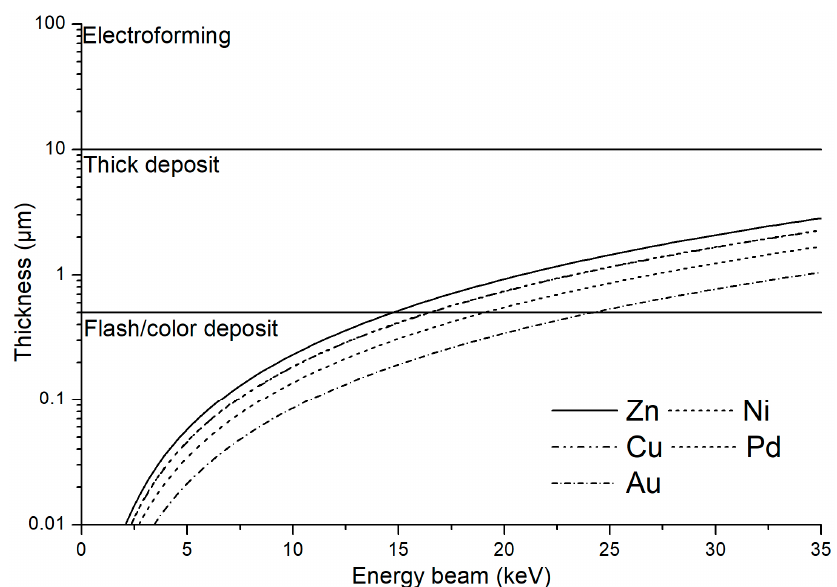
Figure 1. Maximum energy dispersive X-ray spectroscopy (EDX) mesurable thickness as function of energy beam, depending on the energy of the beam, for Zn, Ni, Cu, Pd and Au. The typical thickness range of electroplated coatings for decorative applications is also shown.